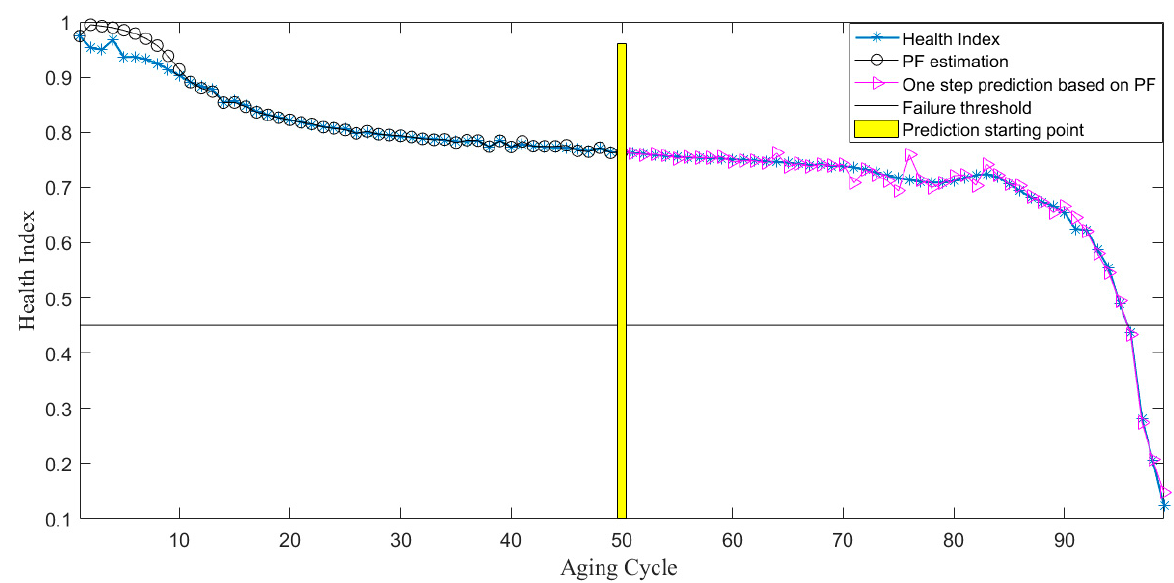
Figure 12. Prediction of particle filtering algorithm at the beginning of cycle 50 of the electromagnetic coil.